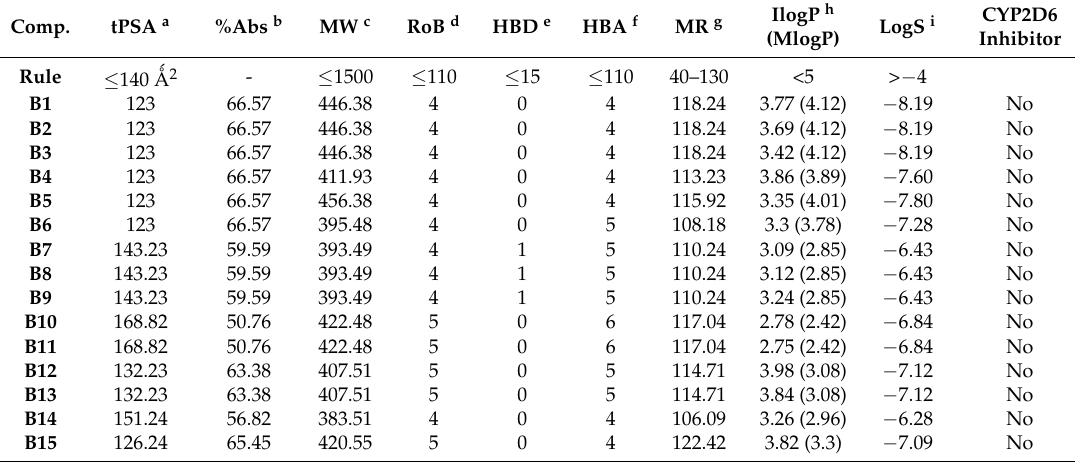
Table 5. Virtual ADME (absorption, distribution, metabolism, excretion) and molecular property prediction of the Schiff bases B1 – B15